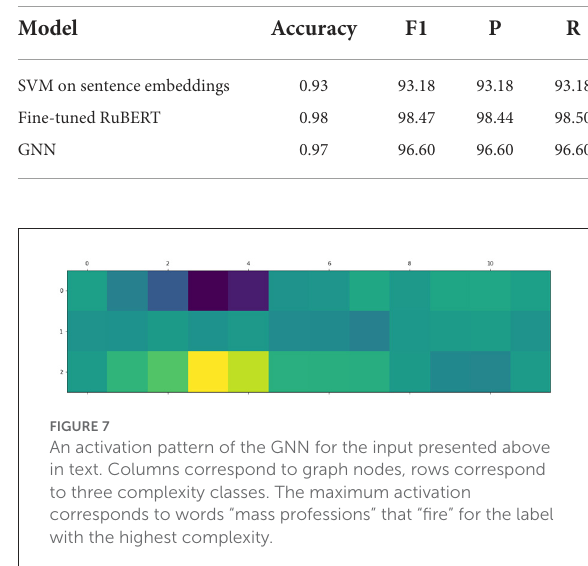
TABLE 7 Binary complexity classification of sentence pairs. 2-s Dataset (with margin = 3)